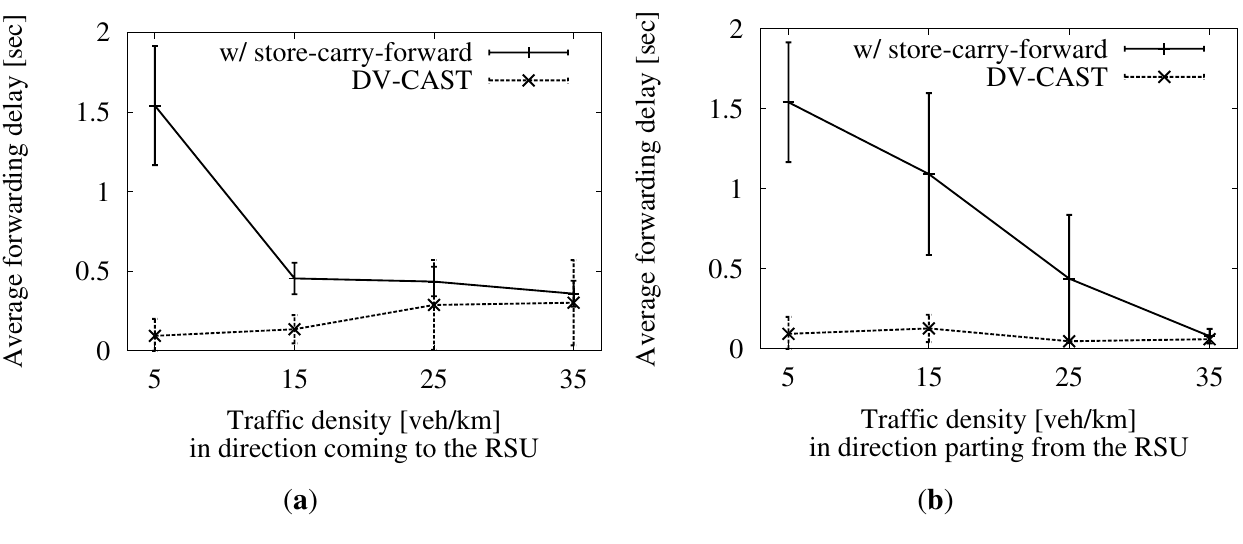
Figure 14. Average delay before forwarding at each hop by our proposal and by DV-CAST. Confidence interval of 95%. ( a ) Five vehicles/km in the direction parting from the RSU; ( b ) five vehicles/km in the direction coming to the